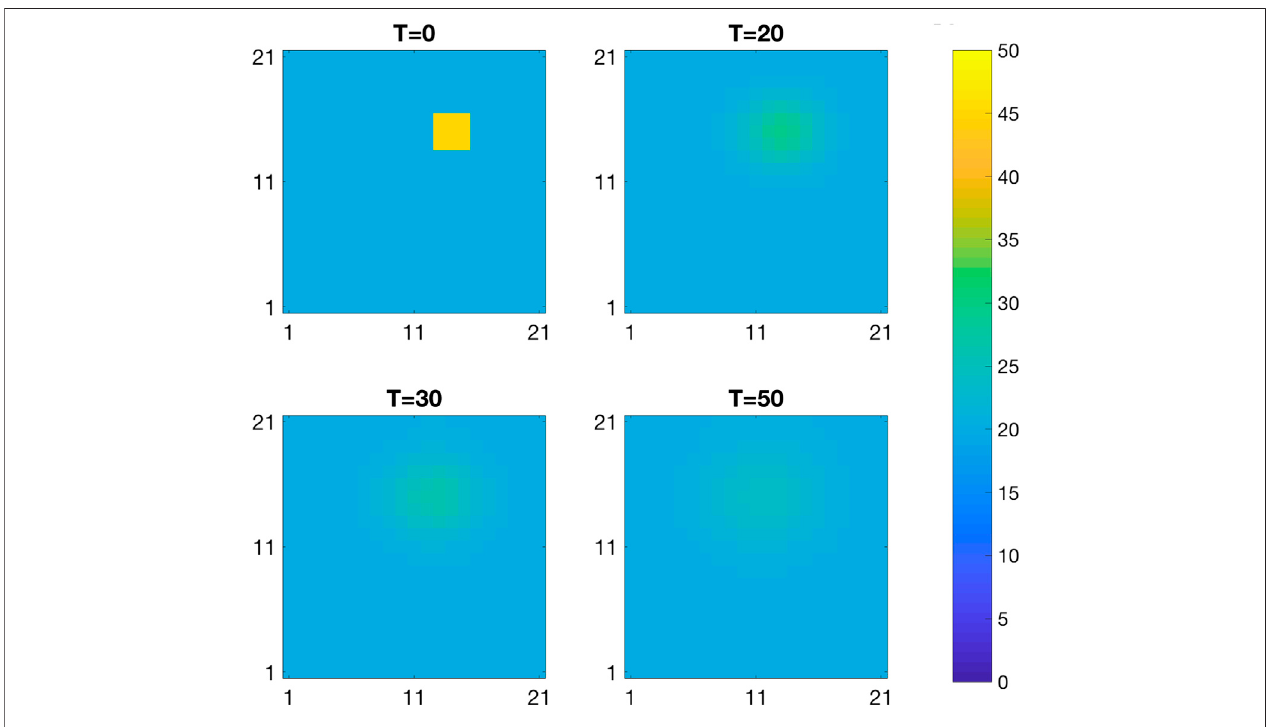
FIGURE 2 | Spatio-temporal